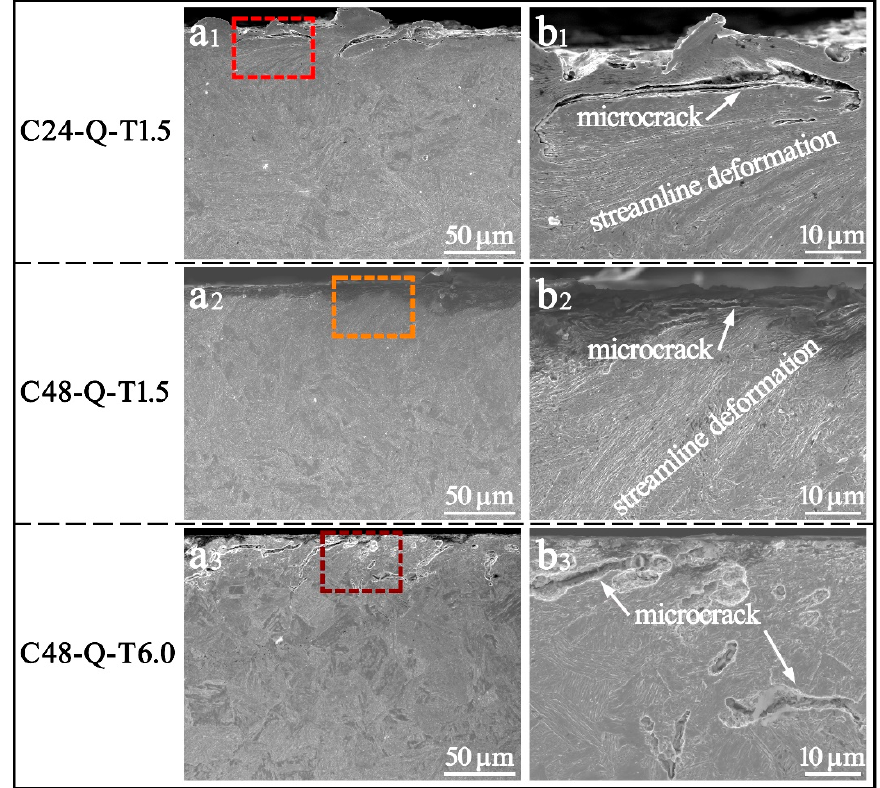
Figure 5. SEM images of the worn section of the specimens processed with different carburiz- ing/tempering durations; ( b 1 – b 3 ) is the magnified map of the selected region in ( a 1 – a 3 ). A gradient decrease in hardness is shown in Figure 6a along the depth below which the surfaces of the specimens were worn after the friction-wear test. The destruction of surface integrity resulted in the softening of the surface layer, while hardness for the core obtained a slight augment mainly due to accumulation of microstrains in the center. In addition, it was observed that the hardness for specimens processed at longer durations of carburizing decreased more compared to specimen C24-Q-T1.5, which could be attributed to the decrease in carbon pinning effects on dislocation migration and reduction in the intrinsic strength of martensite due to the segregation of carbon along the microstructural interface and formation of tempered martensite during cyclic rolling